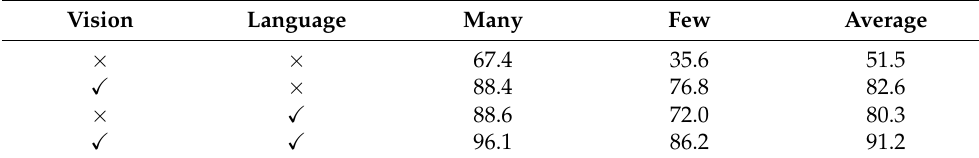
Table 7. Ablation results obtained when fine-tuning on CLIP.